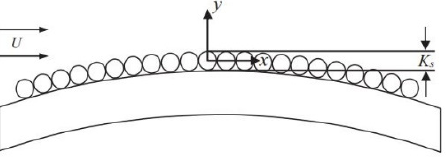
Figure 3. Schematic diagram of equivalent sand model [26].